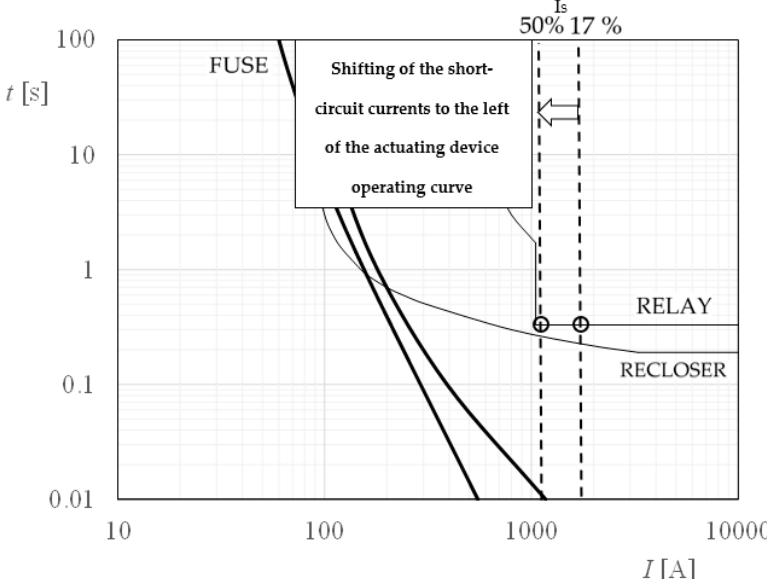
Figure 4. Short circuit downstream of DG. See also Figure 3.